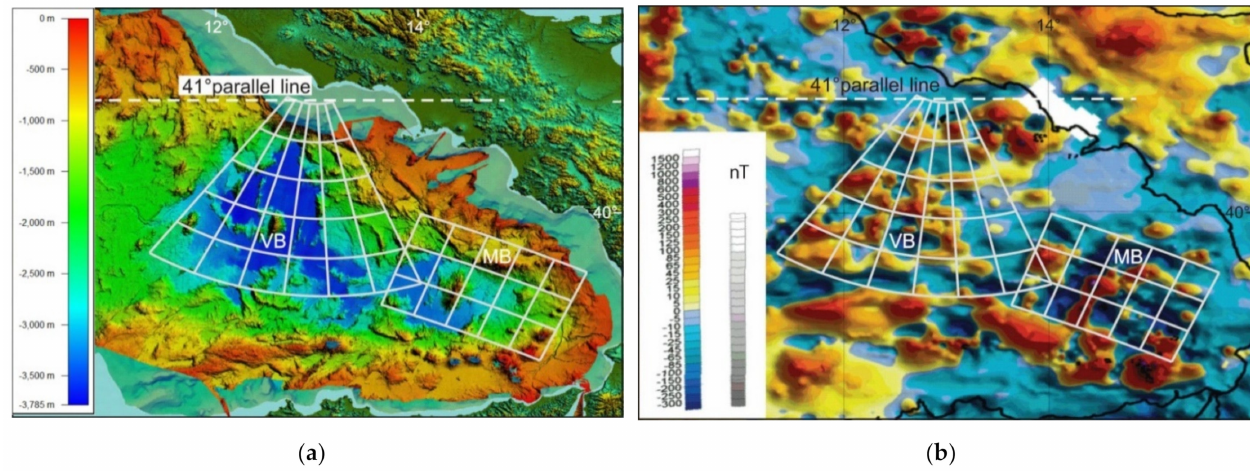
Figure 6. ( a ) Bathymetry [63] and ( b ) magnetic anomalies [64] for the Tyrrhenian basin. White lines show the grid of the rotation pole for: Vavilov (VB) and Marsili (MB) basins. Both basins show magnetic anomalies comparable with the structural lineaments and the geometric shape of the